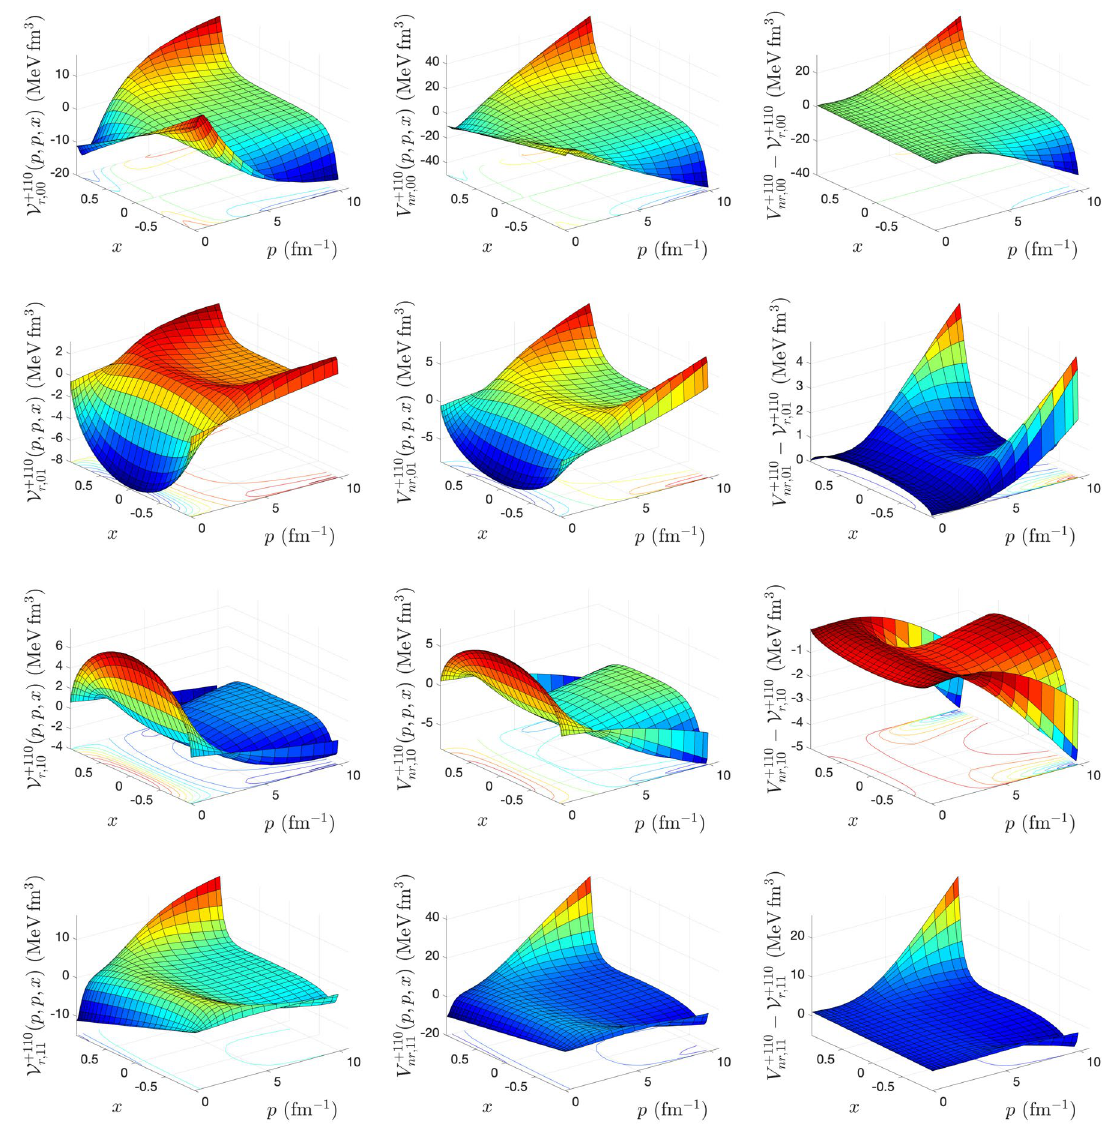
Figure 3. The same as Fig. 1, but for ( s